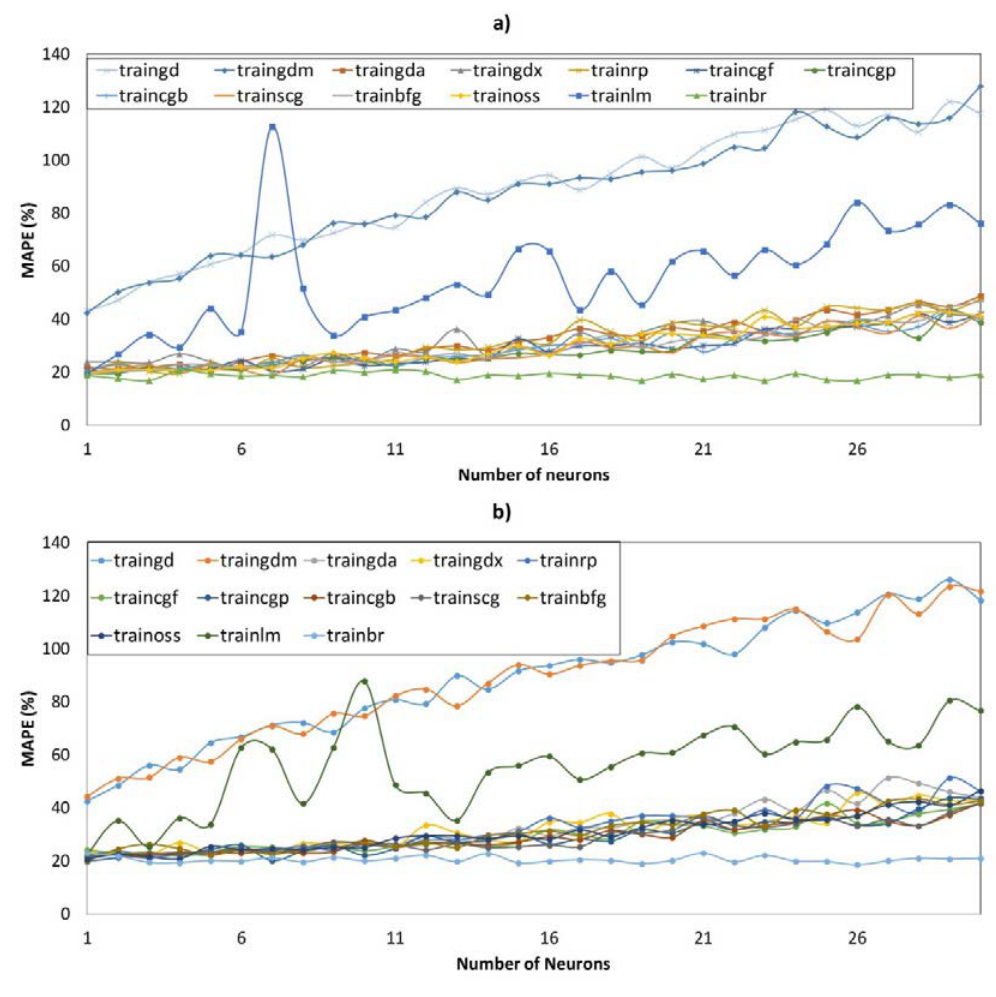
Figure 6. MAPE (%) (5) in each of the models for the Data Set B: ( a ) F_L_W_M ; ( b )